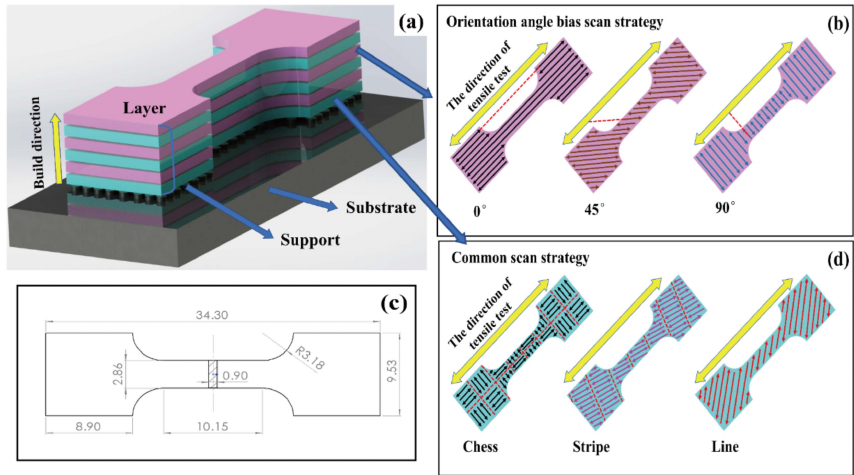
Figure 2. Schematic diagram of the combination of different scanning strategies and the tensile specimen dimensions. ( a ) Schematic diagram of the stacking of different forming layers; ( b ) schematic diagram of the scanning strategy for the directional angle-offset shaping layer; ( c ) L-PBF tensile specimen dimensions; ( d ) schematic diagram of the general scanning strategy shaping layer. The schematic diagram of the combination of different scanning strategies is shown in Figure 3.